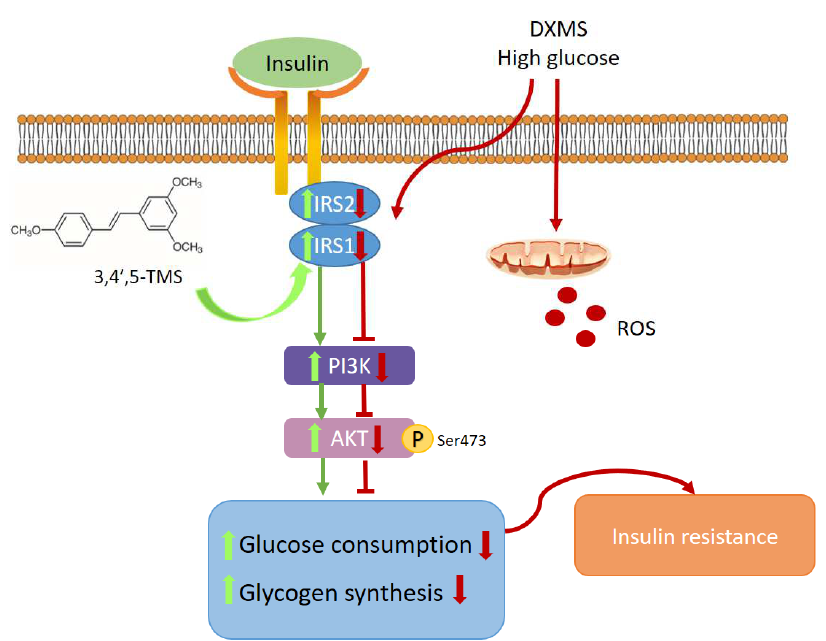
Figure 5. Signaling pathway conclusions. 3,3′,4,5′-TMS ameliorated insulin resistance by suppressing reactive oxygen species (ROS) production and activating insulin receptor substrate (IRS)/phos- phatidylinositol 3-kinase (PI3K)/protein kinase B (Akt) pathway in IR-HepG2 cells.